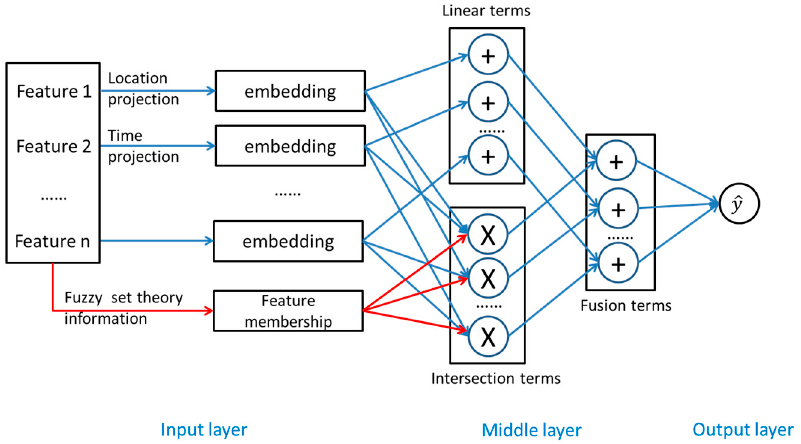
Figure 2. The network architecture of the proposed location-time-aware factorization machine (LTFM) based on fuzzy set theory.